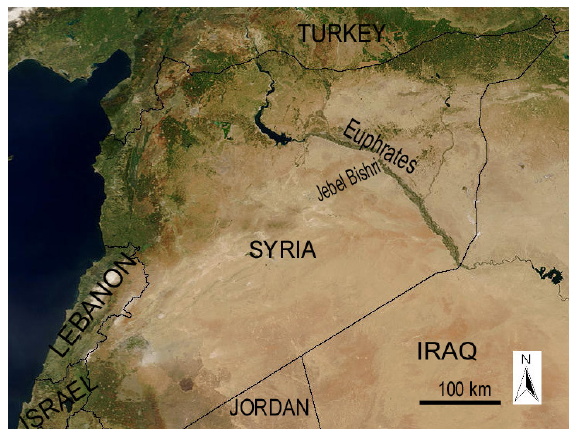
Figure 1. Syria and the location of Jebel Bishri. The connection by a caravan road running through Tadmor (Palmyra) and the Syrian Desert to the Euphrates is already indicated in the Mari cuneiform texts dating from the Middle Bronze Age (18 th century BC) (see, e.g., Joannès, 1997). Later on the Silk Road passed Palmyra (see, e.g., Rostovzeff, 1971), privilege of autonomy of a varying degree during the Roman period. The Strata Diocletiana , the Diocletian road, which marked the Eastern limes of the Roman empire towards the desert, passed the city from the west to east, to the